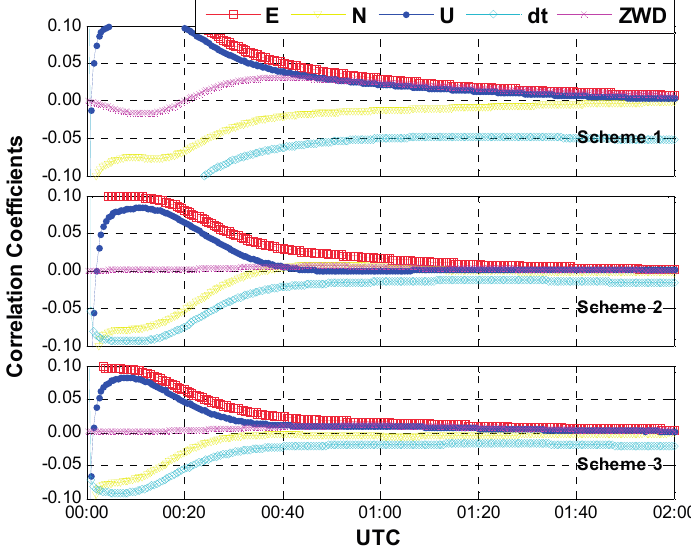
Figure 10. Correlation coefficients between ISB and other parameters (case two: limited number of GPS and GLONASS satellites, an average of 6 satellites